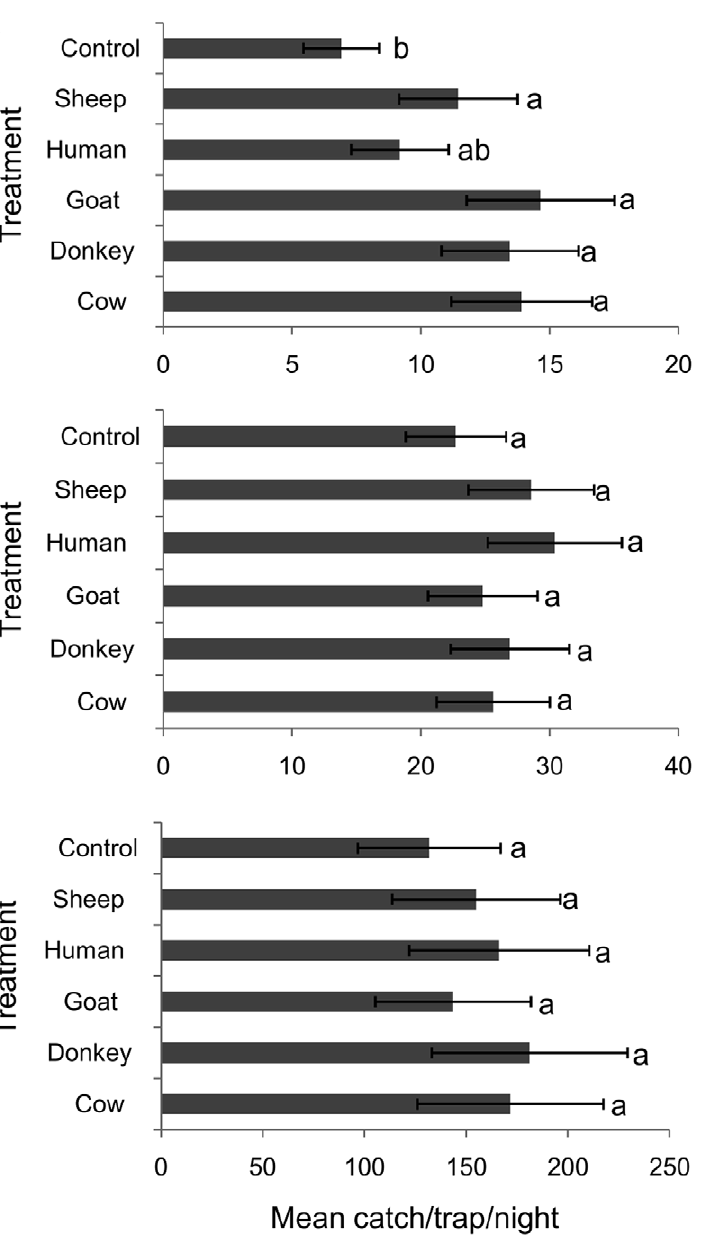
Figure 3. Mean daily captures of RVFV vectors in the different trap treatments in 11 replicate trials. (A) primary vectors ( Ae. mcintoshi and Ae. ochraceus ); secondary vectors comprising (B) total Culex spp.; (C) total Mansonia spp. Control, CO 2 -baited traps only; host treatments represent skin odors from each host type combined with CO 2 . Treatments followed by the same letters are not significantly different at P=0.05 following generalized linear model (GLM) with negative binomial error structure and log link in R 2.11.0 software; Error bars indicate standard error of the mean.